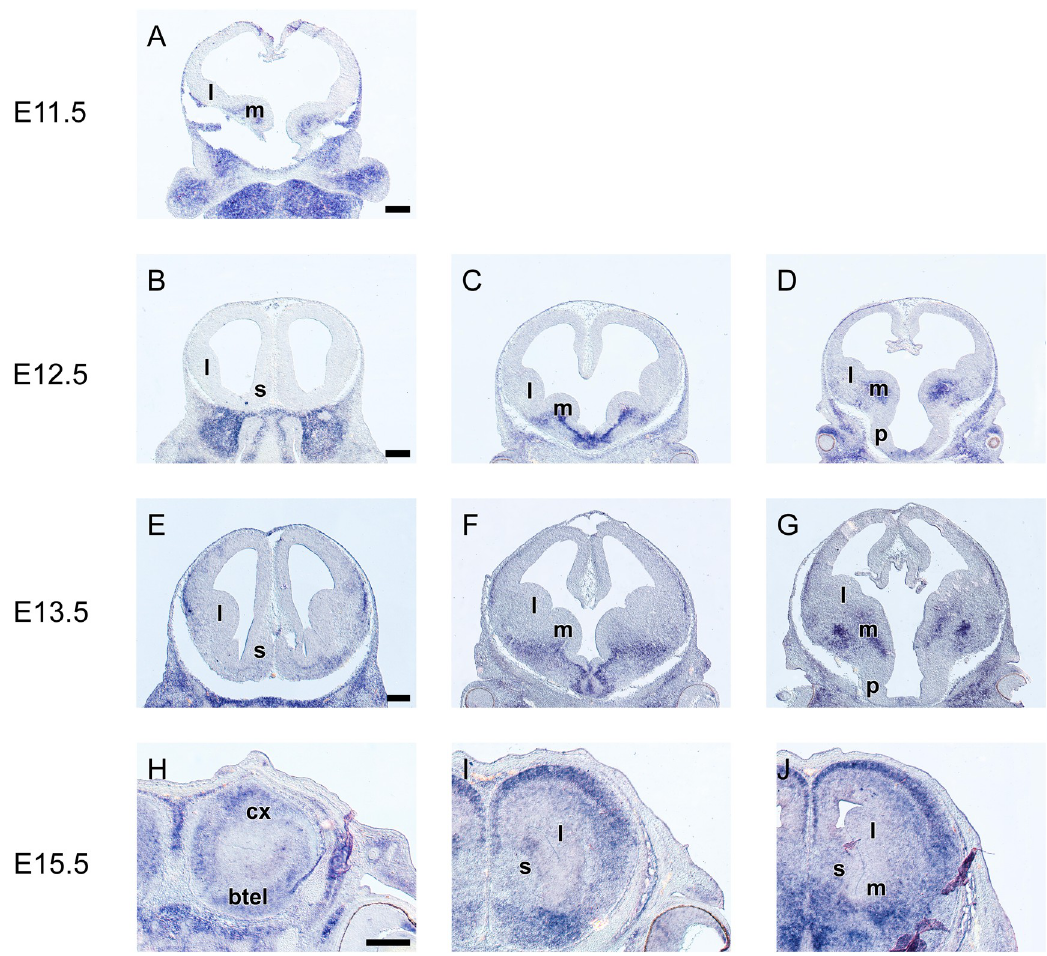
Fig 3. In situ hybridization on coronal sections through the embryonic telencephalon from rostral (rostral (left) to caudal (right) levels hybridized with an antisense RNA probe Grg2 at E11.5 (A), E12.5 (B—D), E13.5 (E-I) and E15.5 (H—J) m: MGE, l: LGE, l: LGE, s: septum. Scale: 250 μ